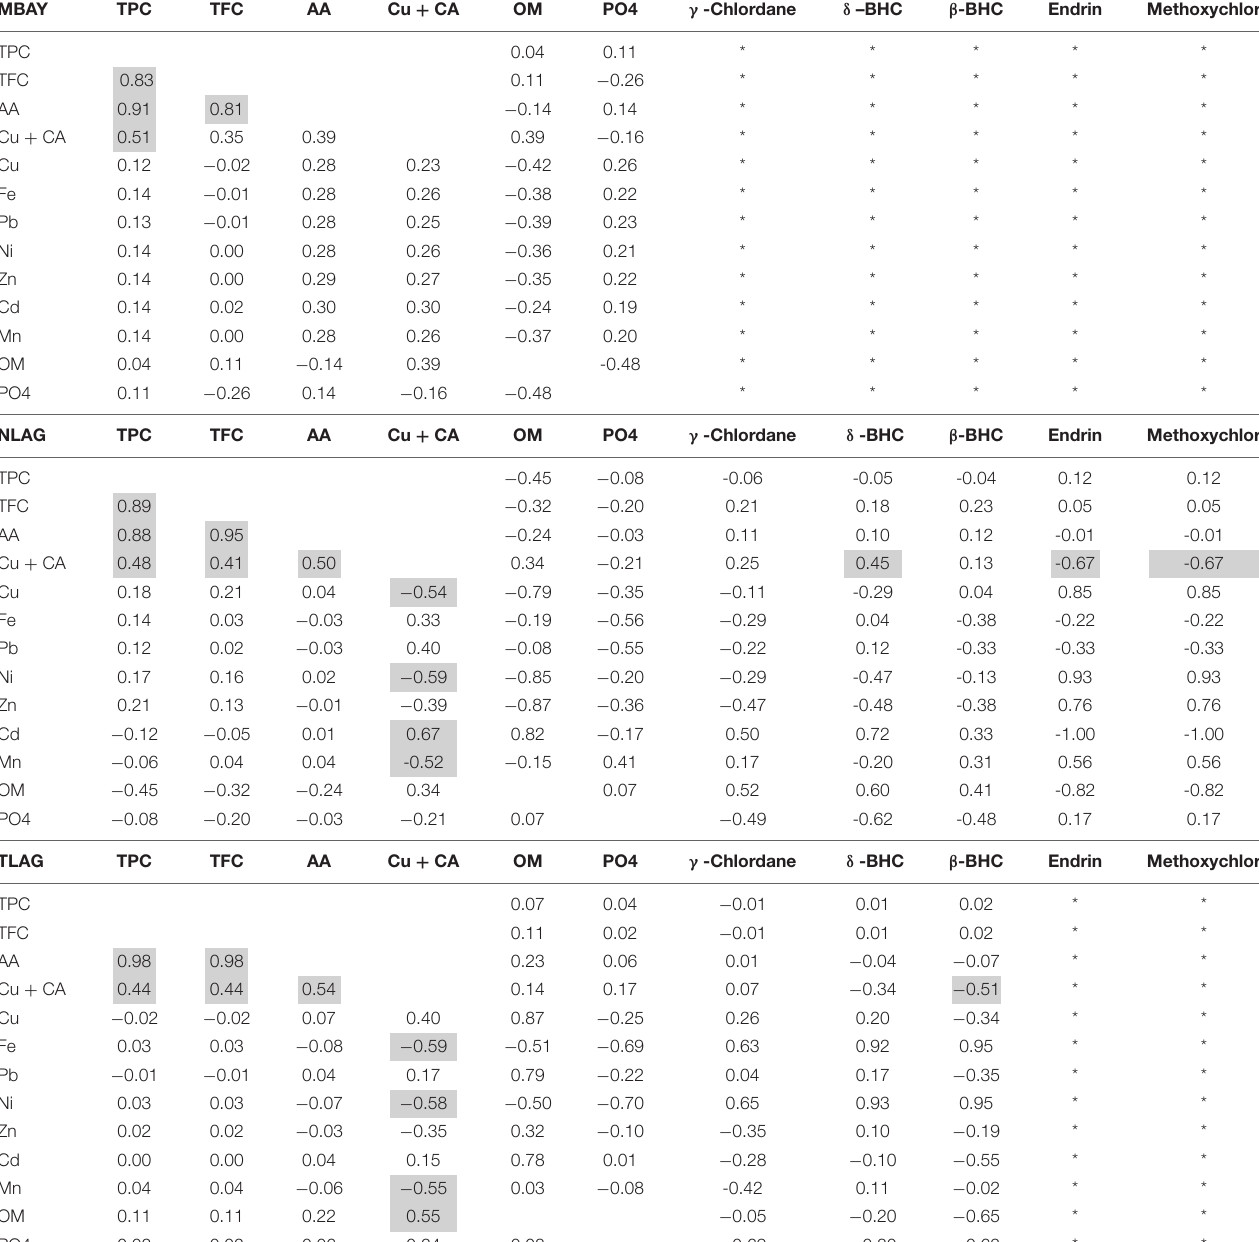
TABLE 1 | Coefficient of correlation among bioactive compounds (TPC, TFC), antioxidant and chelating activities, organic matter (OM), and PO4 of R. mangle and with trace metals and OCPs in sediment. MBAY TPC TFC AA Cu + CA OM PO4 γ -Chlordane TPC